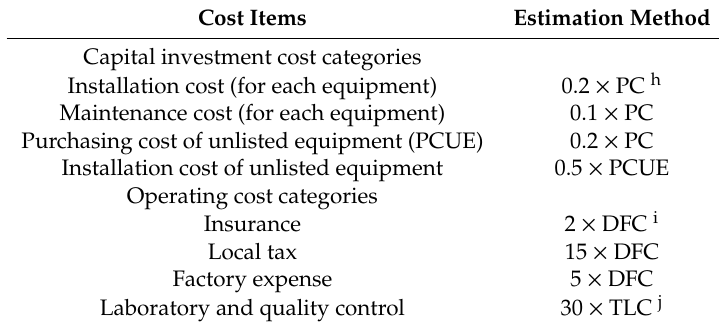
Table 4. Cost estimation methods for components of capital investment and operating